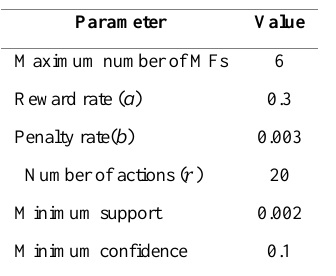
Table 3. Parameters used by